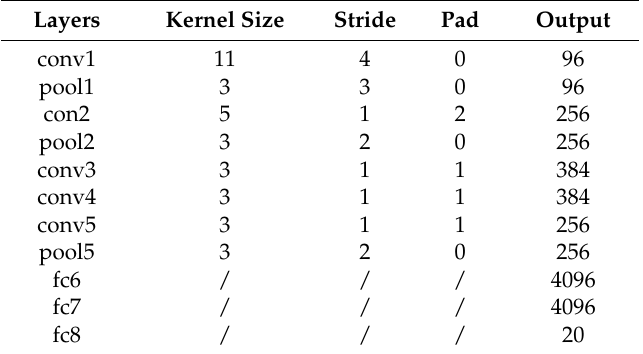
Table 2. Specification of